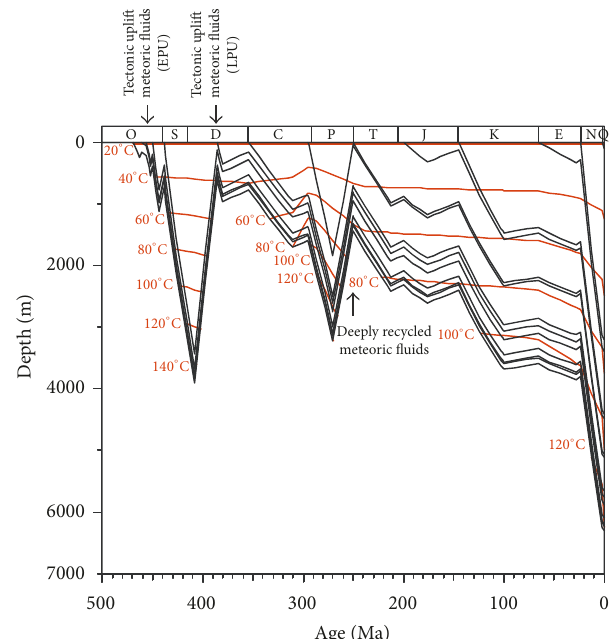
Figure 3: Burial history diagram of Well S109 in the Tahe Oilfield.